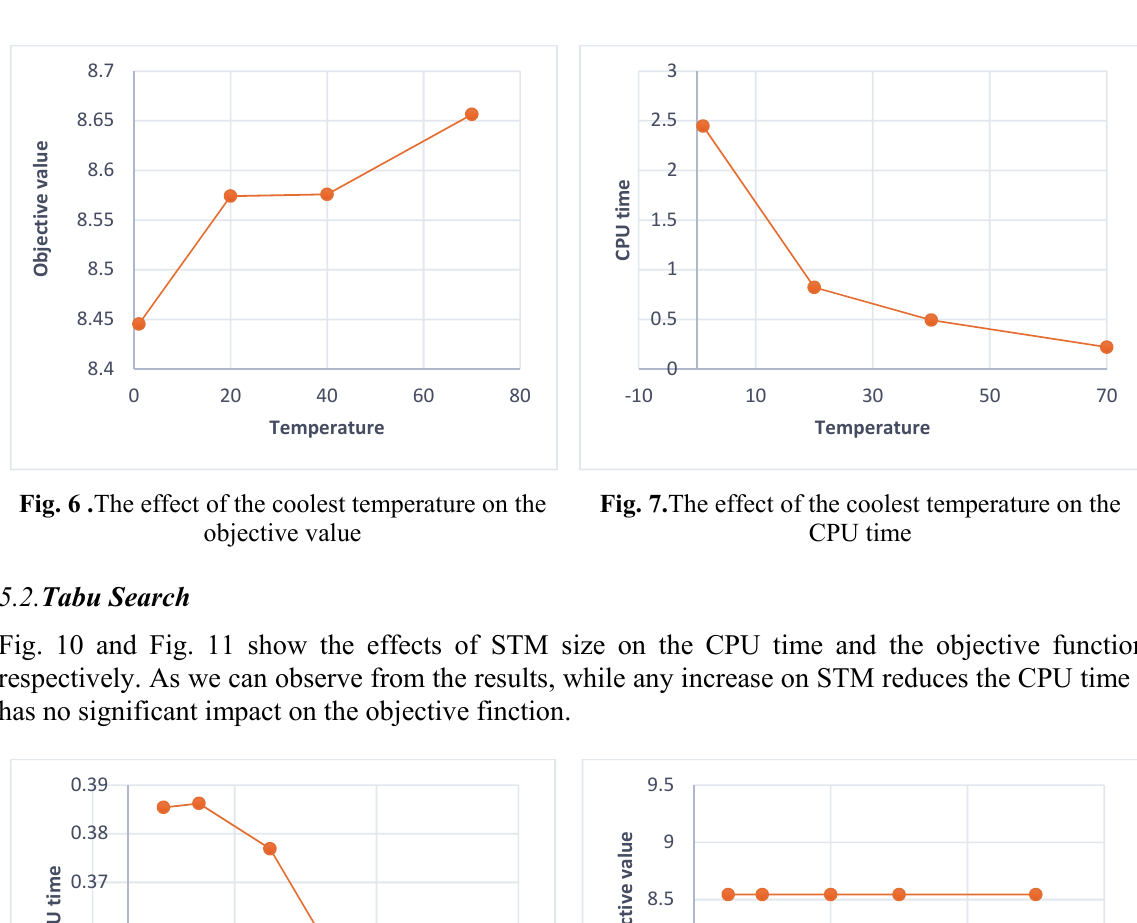
Fig. 8 . The effect of STM size on the CPU time Fig. 9 . The effect of STM size on the objective